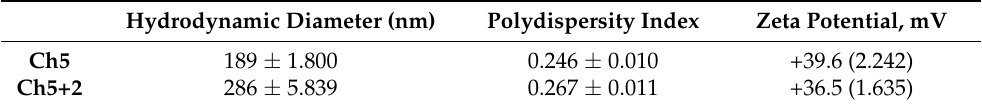
Table 2. The hydrodynamic diameter with the corresponding polydispersity index and the zeta potential measurement of the aggregates in water ( n = 3, ± SD).